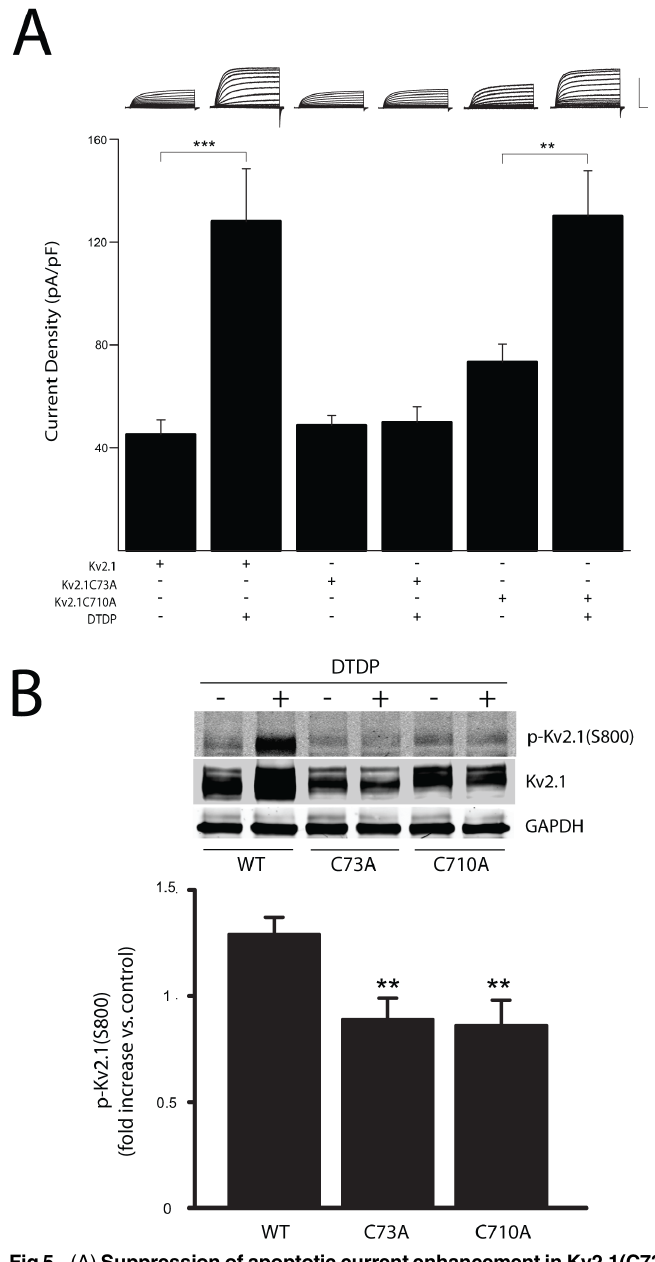
Fig 5. (A) Suppression of apoptotic current enhancement in Kv2.1(C73A)- but not Kv2.1(C710A)- expressing K + channels. Representative whole-cell K + currents and pooled mean ± SEM current densities recorded from Kv2.1-expressing CHO cells without (n = 10) or with (n = 6) 30 μ M DTDP, Kv2.1C73A- expressing CHO cells without (n = 9) or with (n = 7) 30 μ M DTDP, or Kv2.1C710A-expressing CHO cells without (n = 9) or with (n = 12) 30 μ M DTDP. Following DTDP exposure, cells were maintained in the presence of the broad spectrum protease inhibitor 1-3-Boc-aspartyl(Ome)-fluoromethyl ketone (BAF; 10 μ M)- containing medium to enhance viability and facilitate electrophysiological recordings [21]. Results show that expression of the C73A channel mutant, but not the C710A mutant, prevents the increase in Kv2.1-mediated K + currents triggered by DTDP. Currents were evoked by a series voltage steps from -80 mV to +80 mV, in 10 mV increments. To determine current density values, steady-state current amplitudes were measured 180 msec after the initiation of the +10 mV step and normalized to cell capacitance. Scale bars: 5 nA, 25 msec; ** p < 0.01, *** p < 0.001, ANOVA/Bonferroni. (B) Kv2.1WT- and mutants-transfected CHO cells were treated with 30 μ M DTDP for 10 min and incubated BAF (10 μ M)-containing culture medium for 30 – 60 min. Total lysates were collected and ran for western blots (top). The membranes were co-probed with Kv2.1 and